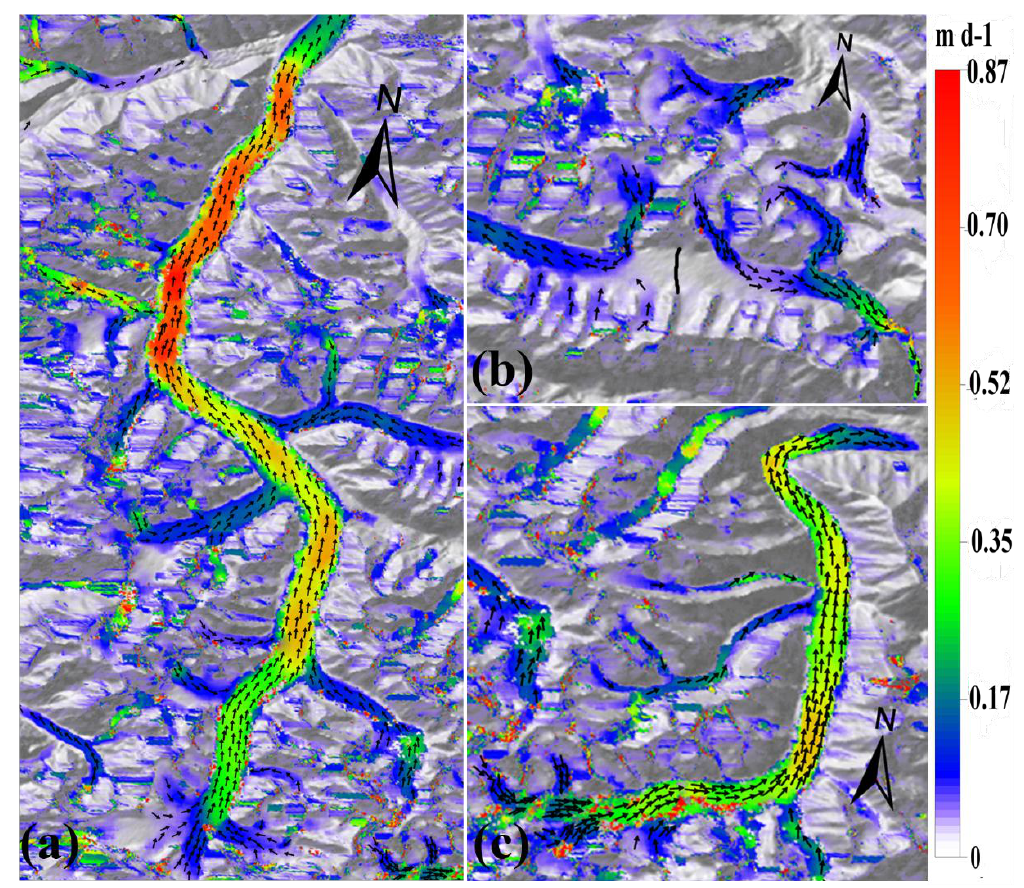
Figure 5. Ice flow direction superimposed on the colored glacier surface